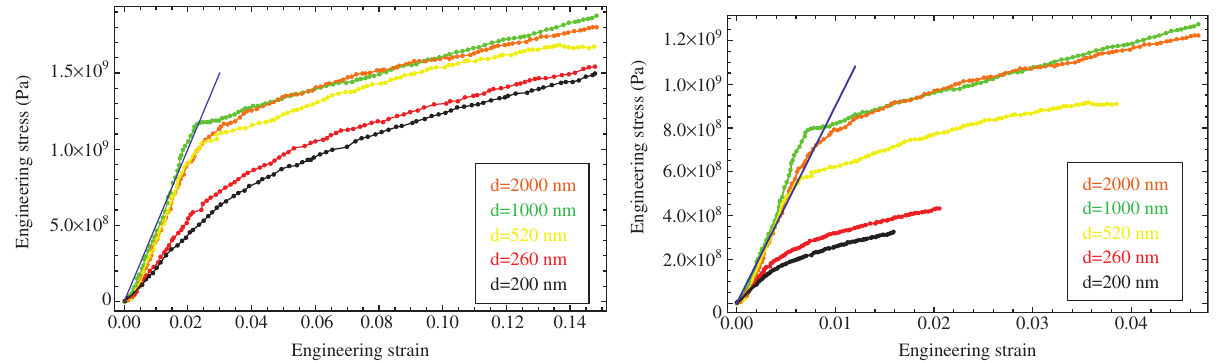
Si metallic Figure 5: Recalculated engineering stress-strain graphs during 77 23 Pd Si metallic glass micropillar compression using Eq. (3). The 77 23 slope of the straight line provides a modulus value of 90